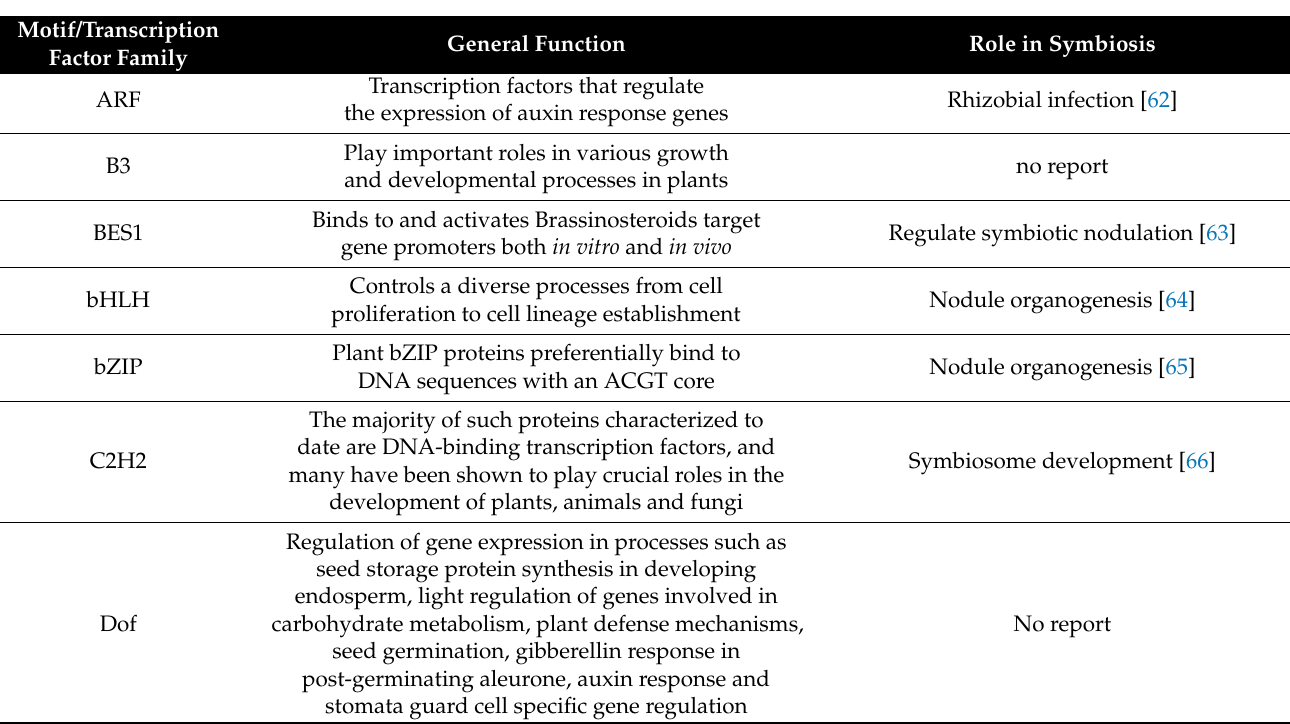
Figure 5. Frequency of PvSnRK cis- acting elements in P. vulgaris . Table 3. Putative symbiosis cis -acting elements of SnRK gene family genes in P. vulgaris , based on studies on symbiotic transcription factors performed in different legumes.